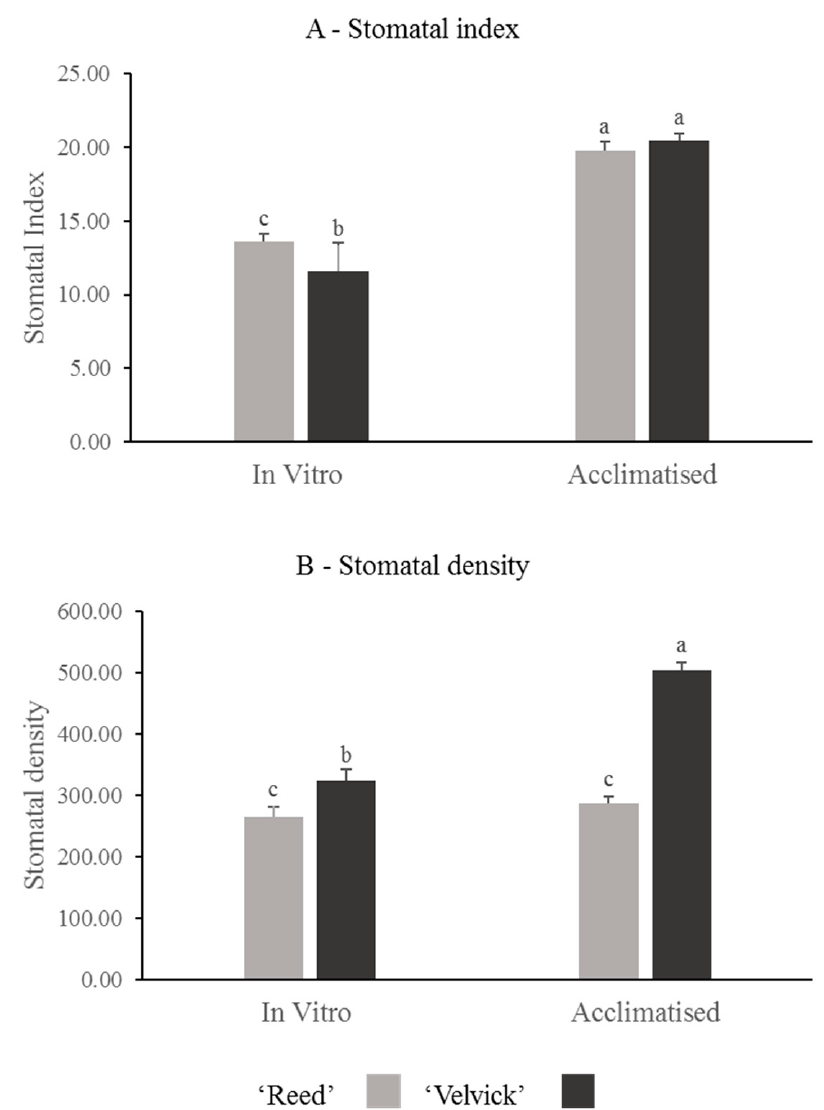
Figure 5. The difference in stomatal index ( A ) and stomatal density ( B ) of avocado rootstocks at in vitro and acclimated stages, as well as changes occur in individual rootstocks during transition. Stomatal index between ‘Reed’ and ‘Velvick’ was significantly different only at in vitro stage ( A ), but stomatal density was significantly different at both in vitro and 1 month into acclimation ( B ). For ‘Reed’, stomatal index was significantly increased during the transition from in vitro to acclimation, whereas for ‘Velvick’ both stomatal index and stomatal density are increased. The letters a, b and c indicate significantly different values within a tested stage between two rootstocks and between the two stages (in vitro and acclimated) at confidence level p = 0.05, n = 10 with two replicates and error bars indicate standard